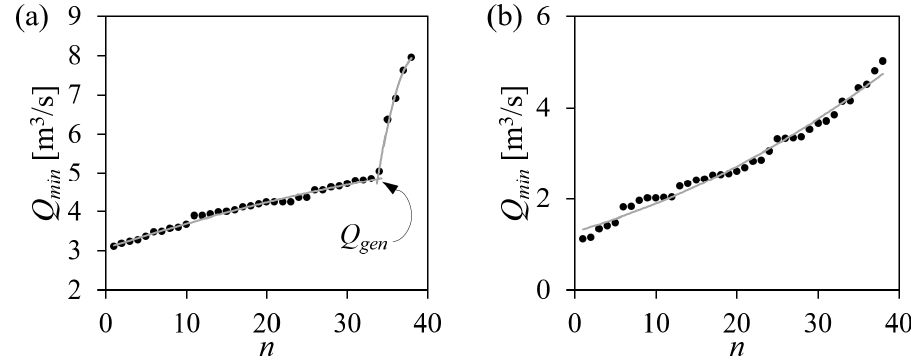
Figure 3. Trend change method for finding the threshold ( Q gen ) based on Tomaszewski’s method [48], on the example series of minimum annual flow values ( Q min ) sorted increasingly ( a ) and the example series for which no clear trend change is present ( b ).